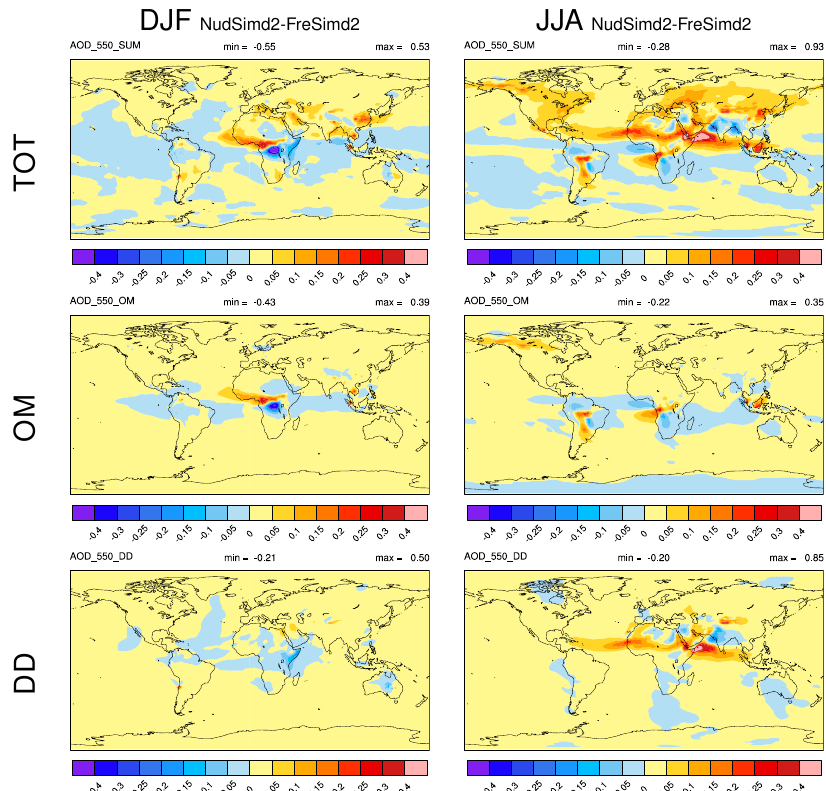
Figure 3. Differences in AOD between the NudSimd2 and the FreSimd2 simulations, for DJF (left column) and JJA (right column), and for total AOD (first row), OM AOD (second row) and DD AOD (last row).